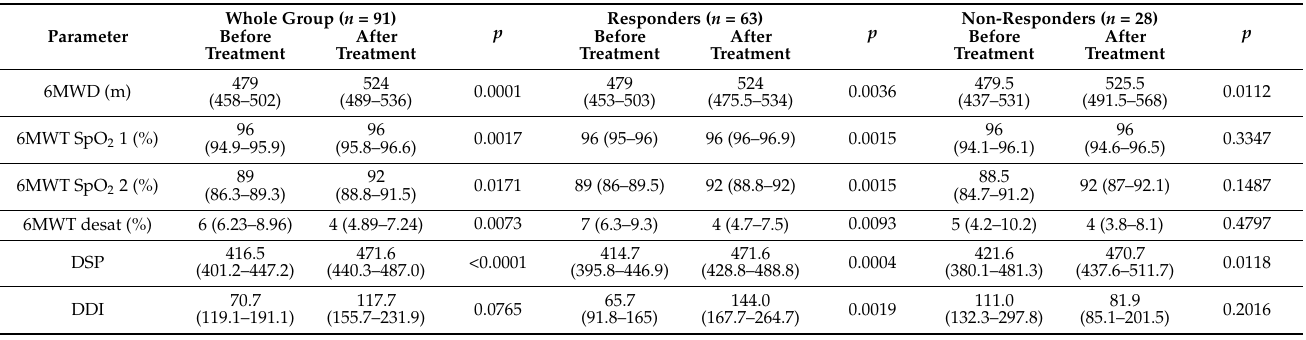
Table 5. 6MWT results (medians with 95% CI) before and after treatment according to treatment response (Wilcoxon